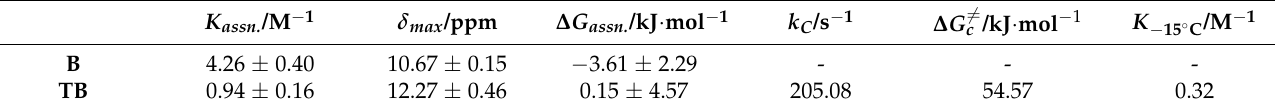
Table 1. Association constant K assn. , maximum chemical shift of N-H δ max , Gibbs free energy of association ∆ G assn . , coalescence rate constant k C , Gibbs free energy of coalescence ∆ G (cid:54) = c , and exchange equilibrium constant K − 15 ◦ C of model compounds B and TB .